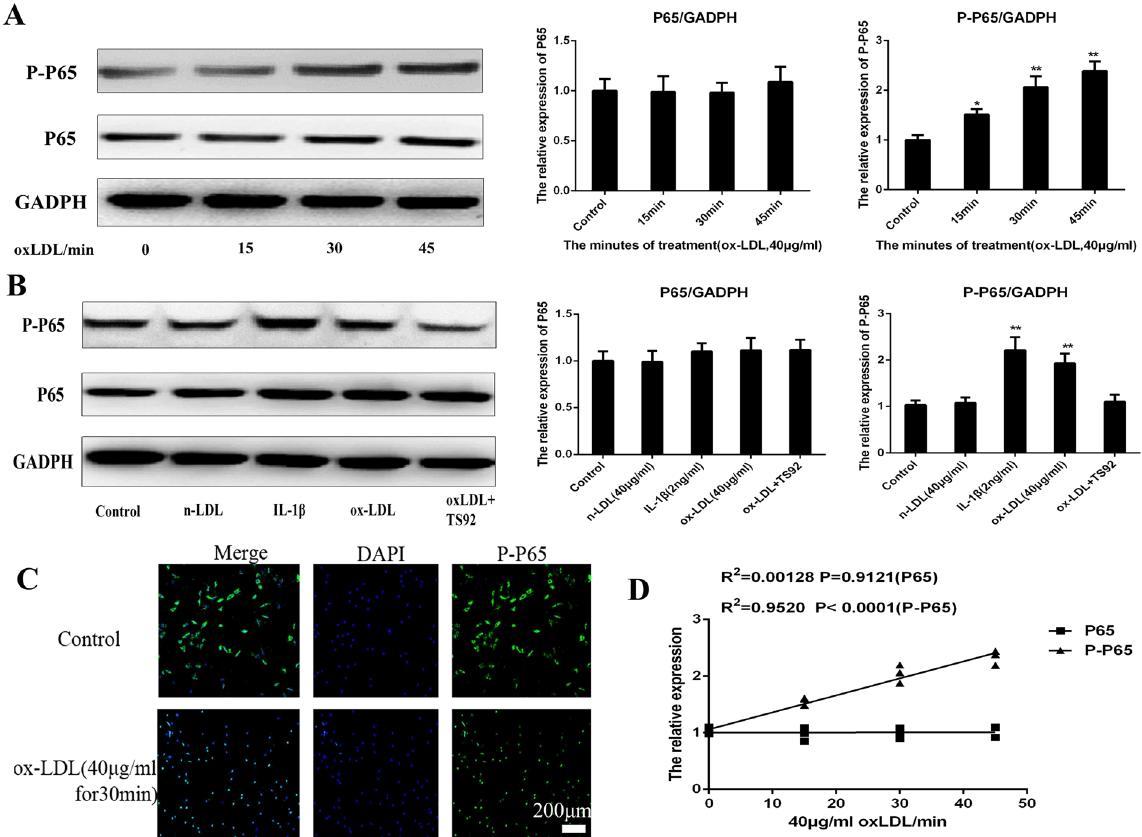
Figure 6. OxLDL can increase the expression of MMP3 by activating the NF- κ B signal pathway. ( A ) Western blotting analysis for the protein expressions of P65 and PP65. Nucleus pulposus cells were treated with 40 μ g/ ml oxLDL for different periods (0, 15, 30, 45 min). The expressions of P65 and PP65 was quantified. Data were presented as mean ± SD from three independent experiments. ( B ) Western blotting analysis for the protein expressions of P65 and PP65. NPC were respectively incubated with 40 μ g/ml n-LDL, 2 ng/ml IL-1 β , 10 μ M ascorbic acid, 40 mg/ml ox-LDL, or preincubated with 15 mg/ml anti-human LOX-1 mAb (TS92) for 24 h than stimulated with ox-LDL for 48 h. The cells without oxLDL treatment were served as control. It shows that IL-1 β and ox-LDL could improve the expression of PP65 (P < 0.01); n-LDL did not affect PP65 expression (P > 0.05) and pretreatment of NPCs with TS92 significantly suppressed the increase in expression of PP65 by ox-LDL. A one-way ANOVA were used for statistical assessments. ( C ) Representative fluorescent microscopic images of Hoechst/PI double stained nucleus pulposus cells showing that the 40 μ g/ml oxLDL can promote the PP65 enter into the cell nuclear from cytoplasm from 0–45 min (only show 30 min). Bars = 200 μ m. ( D ) The Correlations analysis between the stimulate period and the expression of P65, PP65 were performed (R 2 PP65 = 0.00128, P < 0.9121; R 2 P65 = 0.952, P < 0.0001). Data are presented as means ± SD. ( * P < 0.05, ** P <